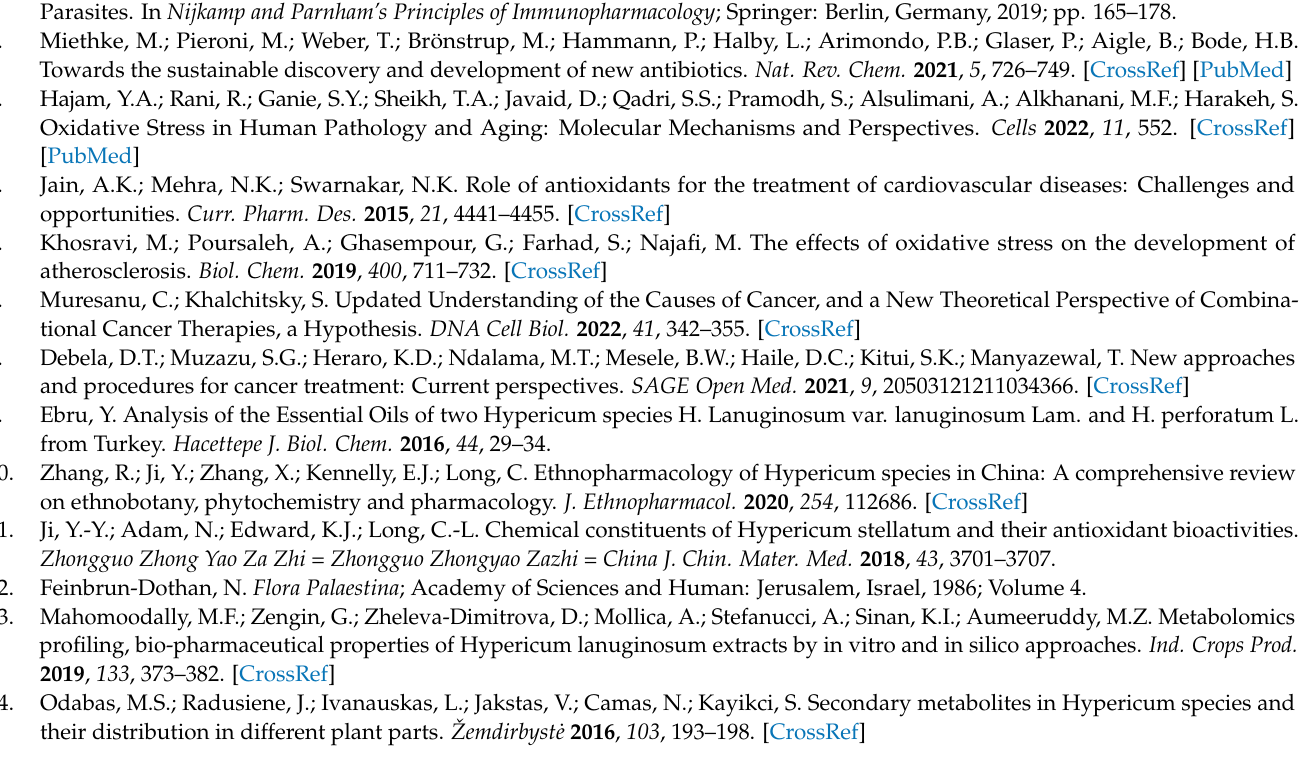
curve; Figure S2. Catechin standard calibration curve; Figure S3. Quercetin reference calibration curve; Figure S4. In vitro free radical scavenging activity of H. lanuginosum extracts and Trolox. Funding: This research did not receive any external